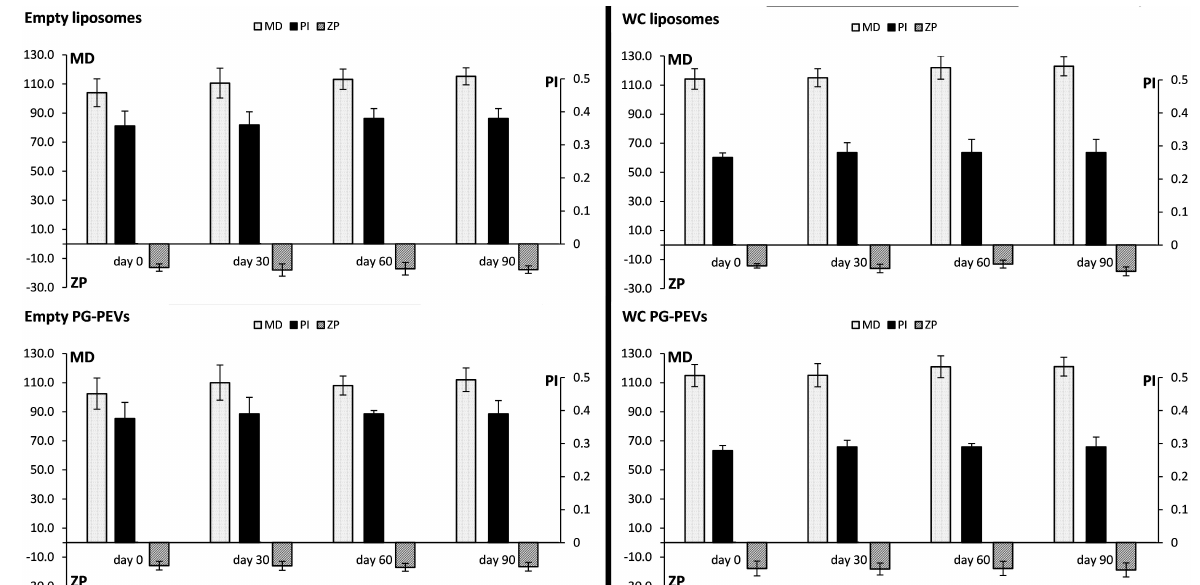
Figure 1. Long-term stability of the vesicle formulations assessed by monitoring mean diameter (MD), polydispersity index (PI), and zeta potential (ZP) for 90 days.